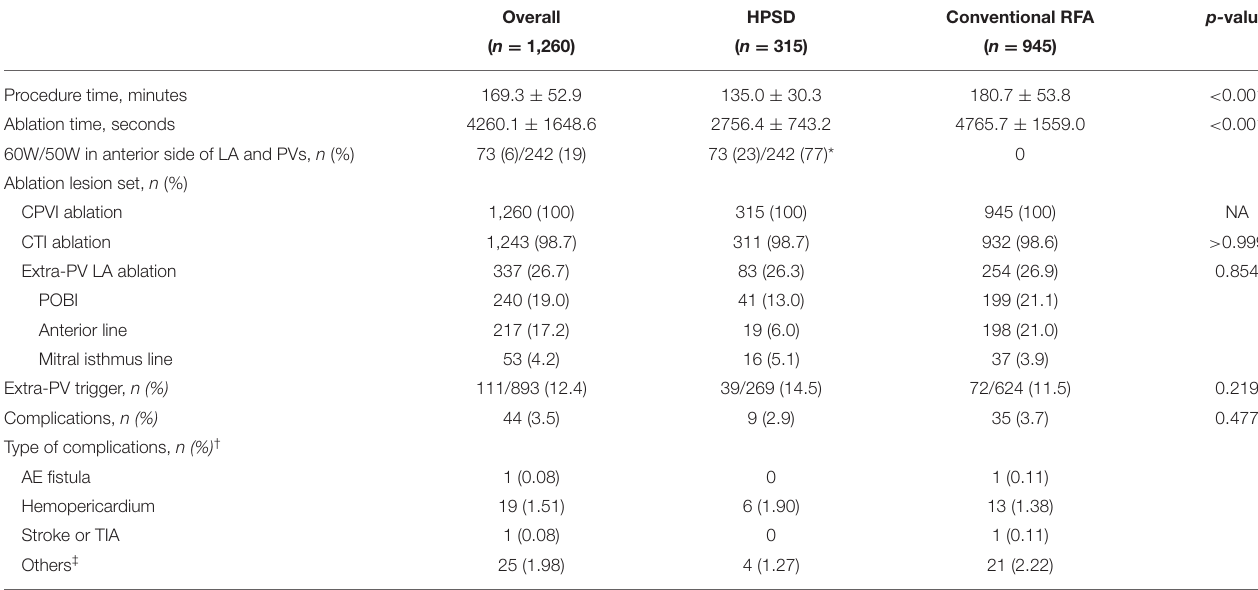
TABLE 2 | Ablation characteristics in propensity-score matched population.